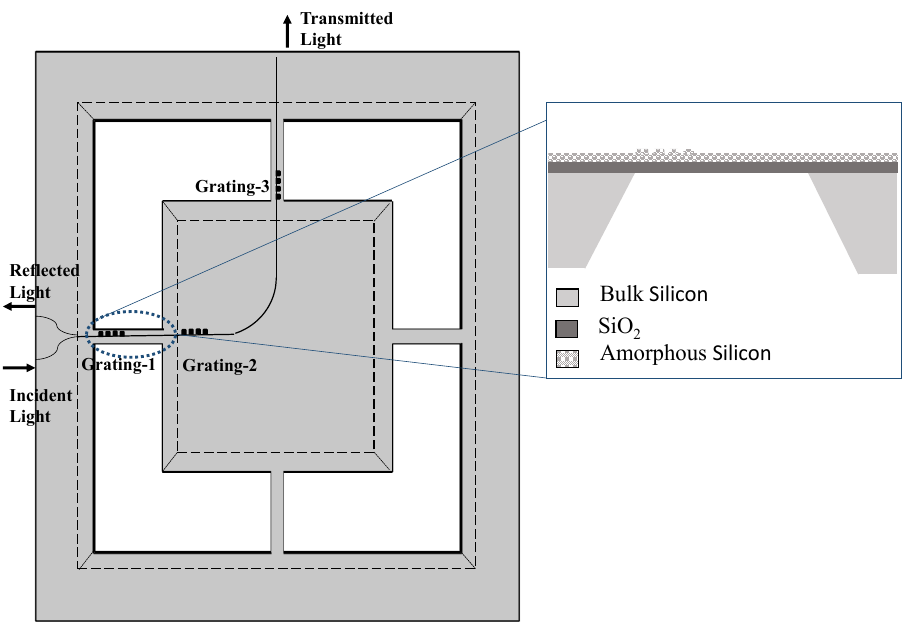
Figure 1. Schematic design of waveguide Bragg grating based Quad-Beam accelerometer: (Inset shows a cross-section view of one beam with amorphous-silicon(a-Si) waveguide and grating).